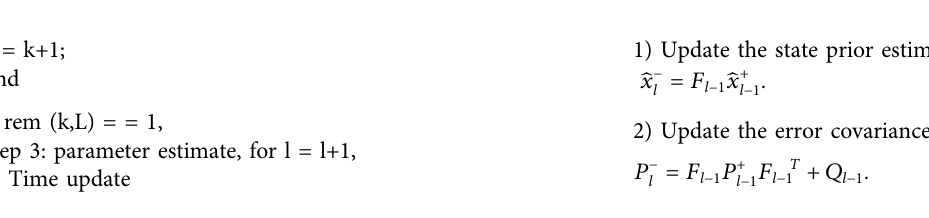
Frontiers in Energy Research |